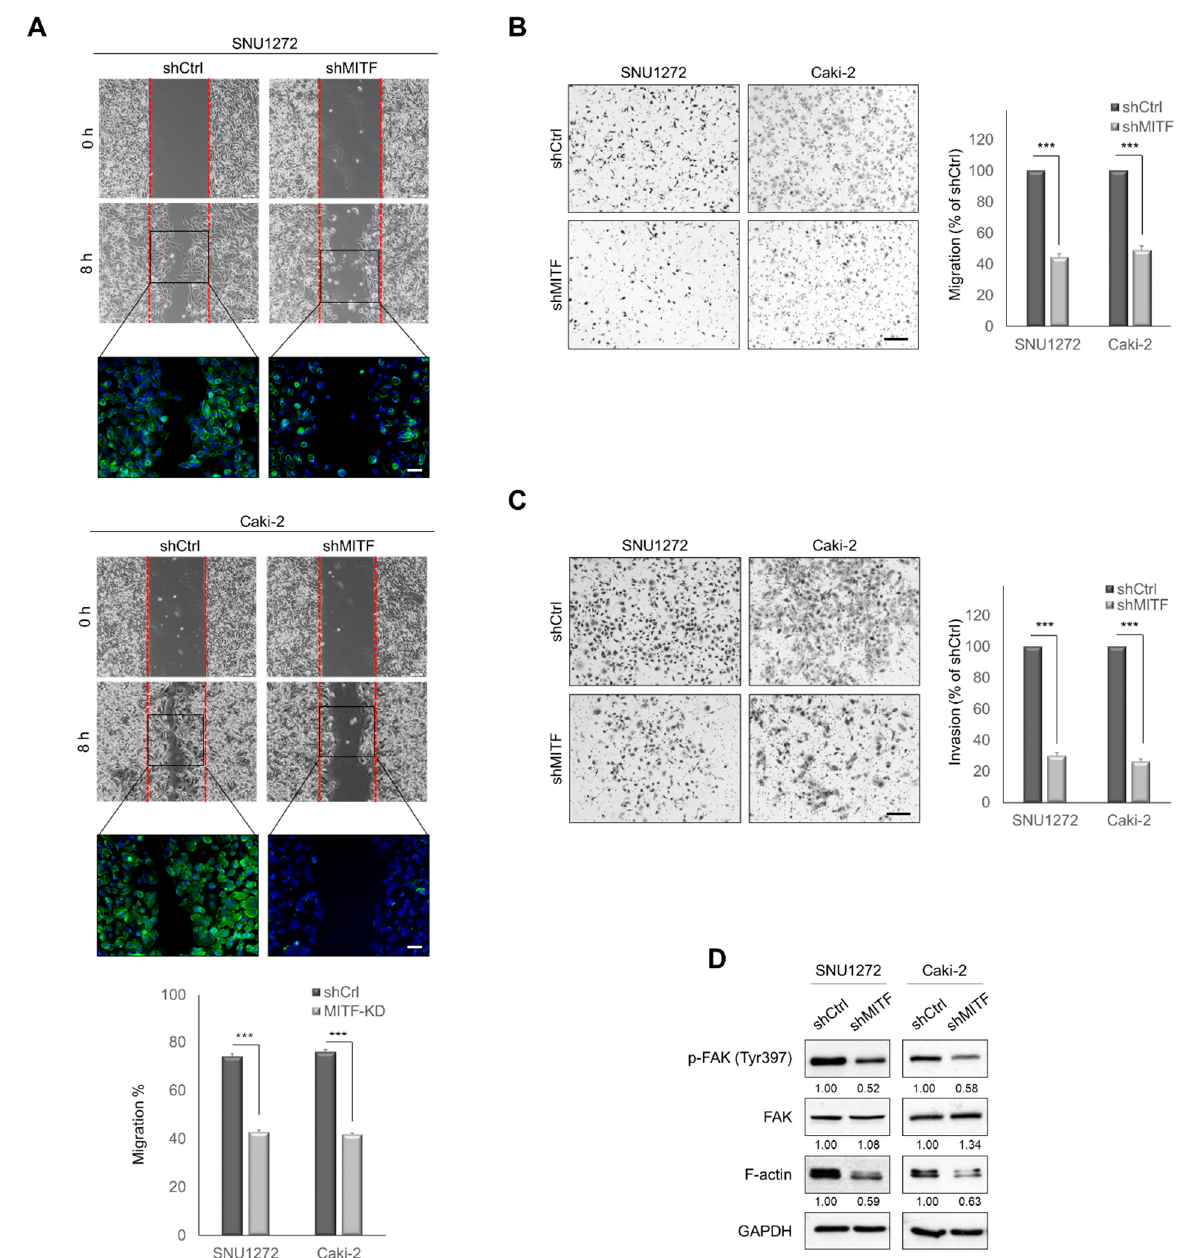
Figure 2. MITF-knockdown suppresses cell migration and invasion in vitro. ( A ) Wound-healing assay in MITF-knockdown and shCtrl cells at 0 and 8 h. Scale bars, 100 µ m. Square box indicates FITC-conjugated phalloidin staining by immunofluorescence microscopy ( × 400). Data are presented as the means ± standard deviation and were evaluated using Student’s t -test ( n = 3). Scale bars, 20 µ m. ( B , C ) Transwell migration and invasion assays. The number of cells in five randomly chosen fields was counted. Data are presented as the means ± standard deviation and were evaluated using Student’s t -test ( n = 3). Scale bar, 200 µ m. ( D ) Western blot analysis of phosphorylated FAK and F-actin expression in MITF-knockdown cells. Whole areas were measured using Image J software ( n = 3). Uncropped blots are shown in Figure S7. ***, p < 0.001.